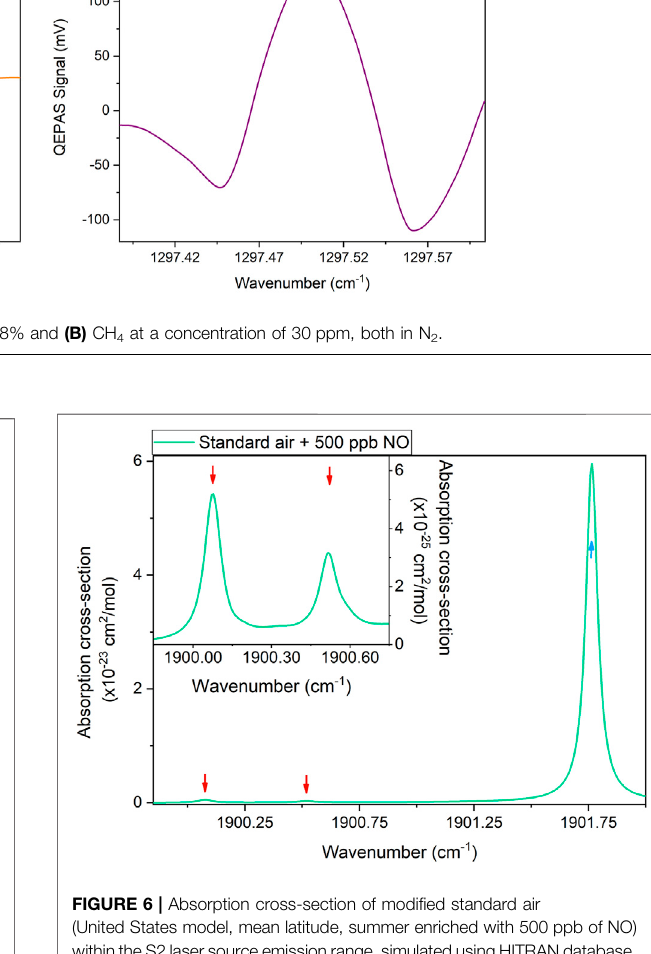
FIGURE 5 | QEPAS peak signals as a function of the CH 4 concentration (purple dots) and the corresponding best linear fi t (purple dashed line).